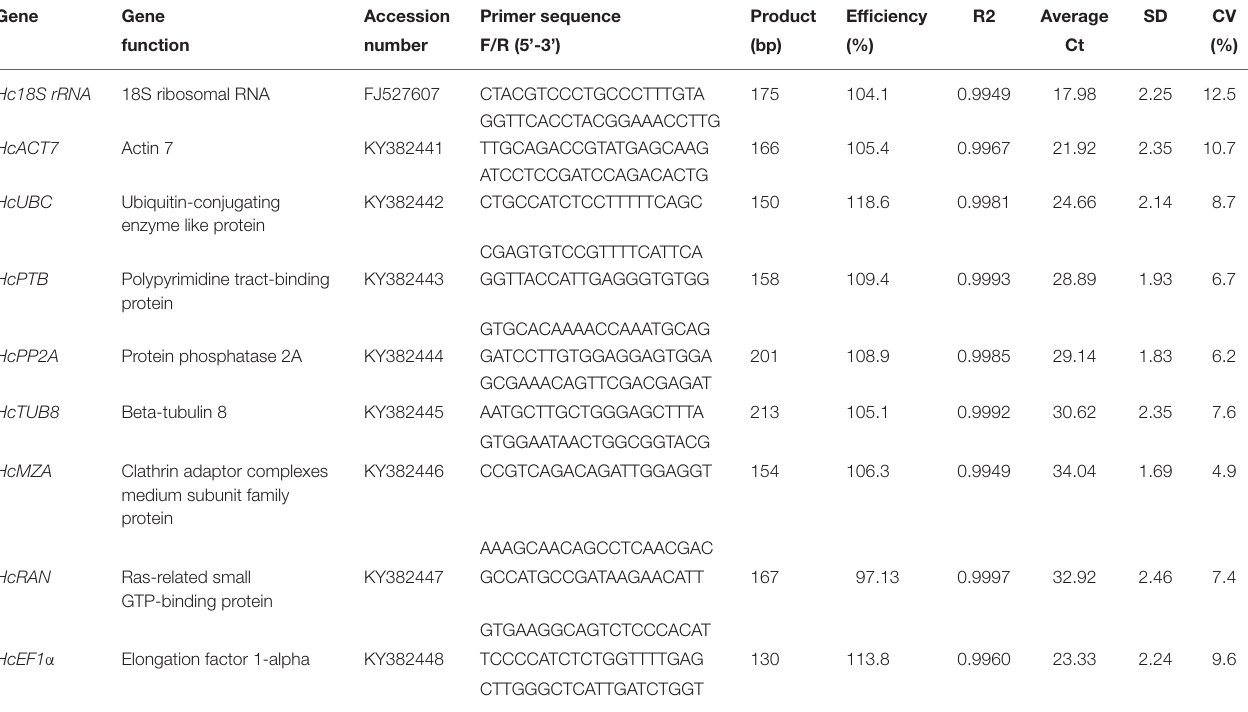
TABLE 1 | Characteristics of nine candidate reference genes in H. cannabinus and parameters derived from qRT-PCR analysis. Gene